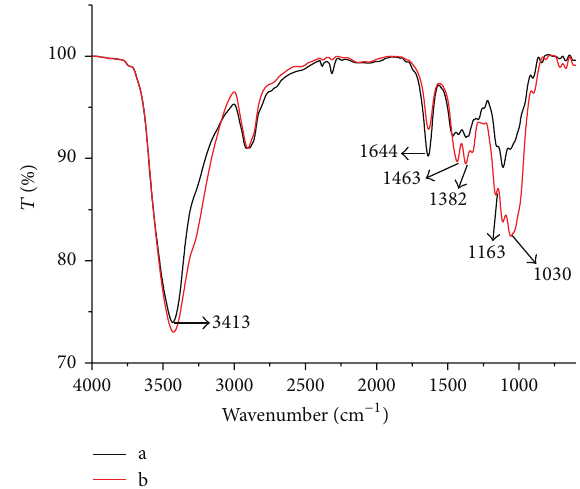
Figure 3: FTIR spectrum of UMCF (Spectrum a) and CMCF (Spectrum